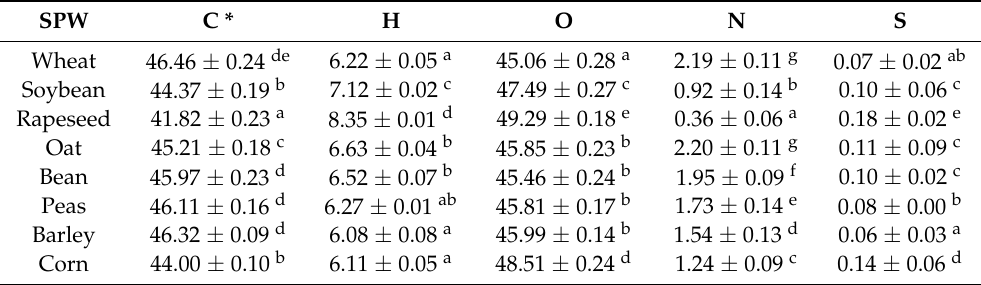
Table 2. Ultimate analysis of individual SPWs (oven dry basis). Statistically significant differences (at p < 0.05) are shown by different superscript letters in the vertical columns ( n = 4). SPW C